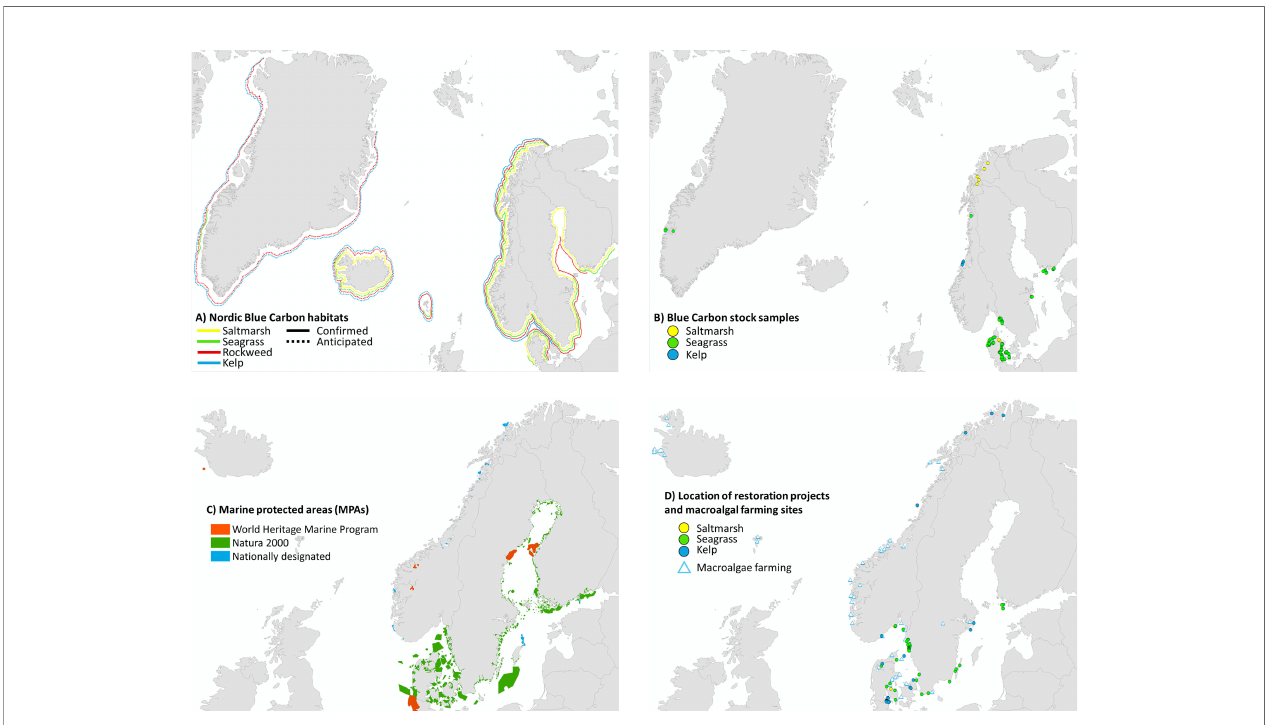
FIGURE 2 | Overview of available information on area distribution of Nordic BC habitats (Svalbard not included). (A) Occurrence of con fi rmed (solid lines) and anticipated (dotted lines) Nordic BC habitats (salt marshes, eelgrass, littoral and sublittoral macroalgae) (details in Table 1 ); for Greenland, there are several con fi rmed macroalgal habitats along especially the west coast, and eelgrass habitats in the Nuuk fjordsystem, although only a coarse estimate of area distribution is available. (B) Sites where C-stocks/sequestration have been assessed. (C) Location of Marine Protected Areas (MPA ’ s; including Marine World Heritage sites, Natura 2000 sites and nationally designated MPAs). (D) Location of restoration projects (circles) and macroalgal farming sites (triangles, Arau ́ jo et al. 2021, from EMODNet) across the Nordic countries. Map from Google Earth, symbols from https://ian.umces.edu/imagelibrary/. See Table S5 (C-stocks) and Table S6 (restoration sites) for detailed site